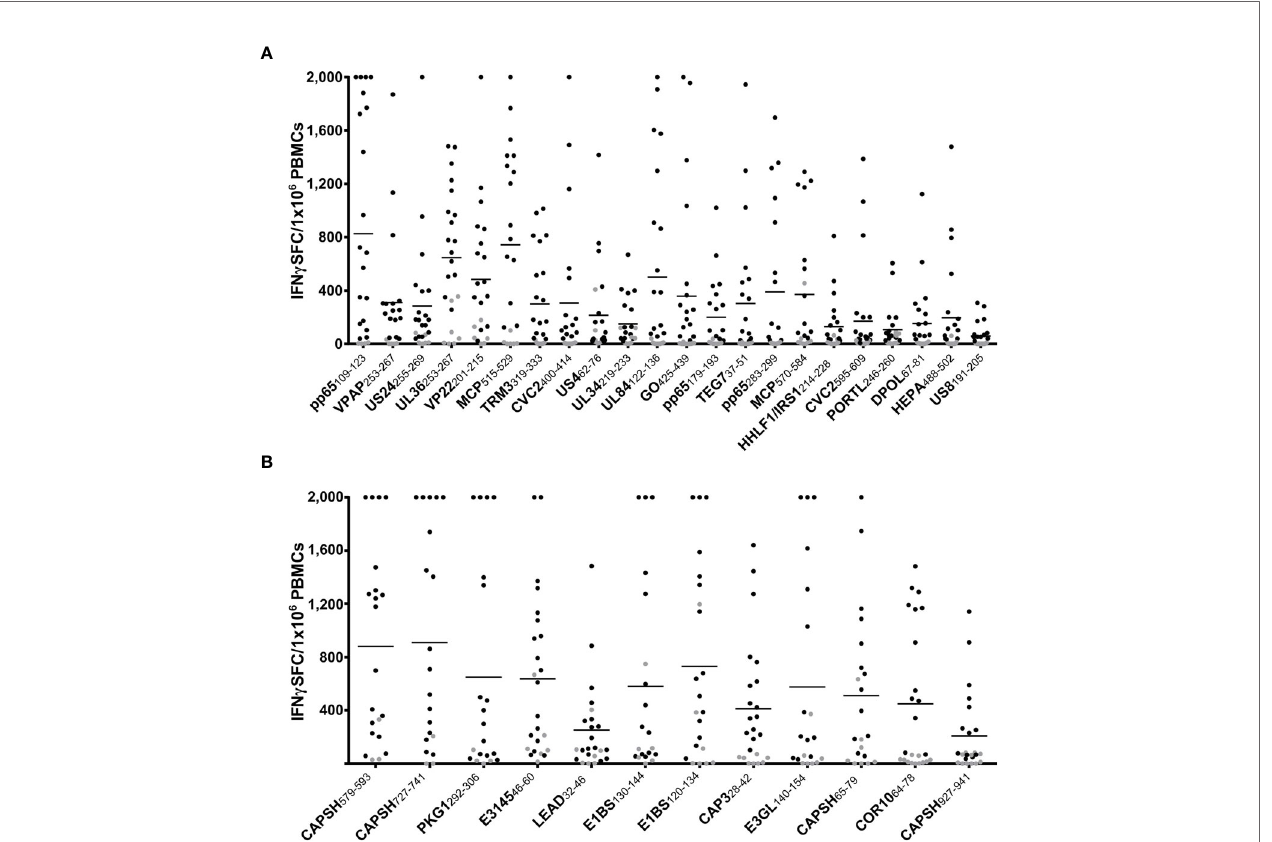
FIGURE 3 | ELISpot screening results of promiscuous epitopes. IFN g T-cell responses in ELISpot assays after 12-day stimulation with peptide and IL-2 to dominant HCMV (A) and HAdV (B) epitopes. The number of spot-forming cells (SFC) per 1x10 6 PBMCs is plotted for each dominant epitope (negative control subtracted, cut- off at 2,000 SFC/1x10 6 ). Each dot represents one tested PBMC culture (n > 20 per epitope). The T-cell response was de fi ned as positive if the spot counts were threefold higher than in the negative control and higher than ten. Negative results are indicated in grey. The horizontal lines show the mean spot counts of all tested PBMC cultures for each peptide. The peptides are sorted according to their recognition rates from highest (left) to lowest